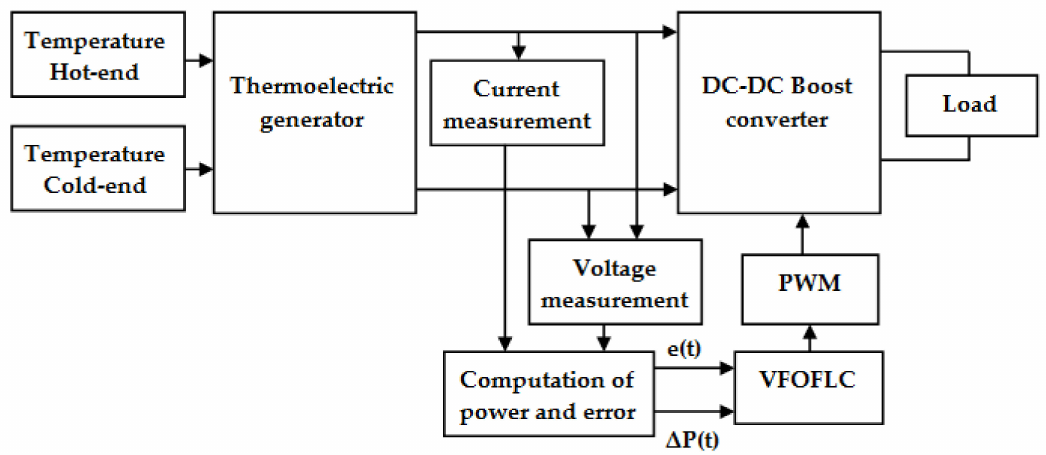
Figure 7. Block diagram of the variable fractional order fuzzy logic controller (VFOFLC)-based maximum power point tracking (MPPT)